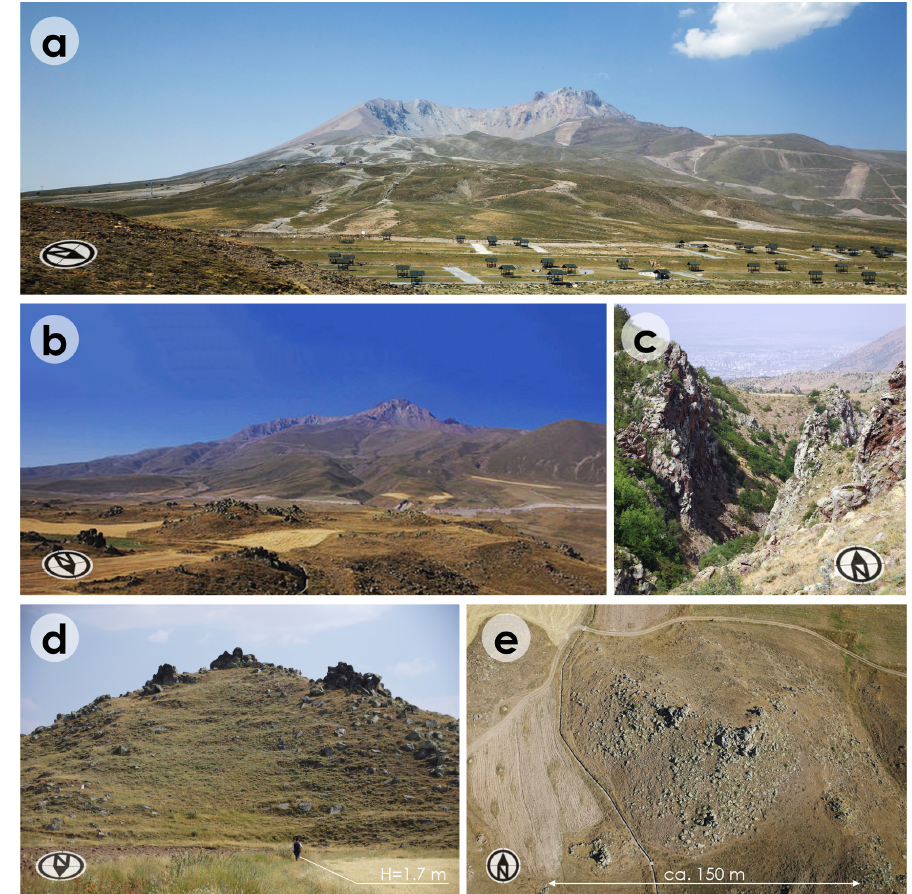
Figure 2. Pictures of the study area. Locations of these photos are shown in Fig. 1. (a) Collapse scar of Mt. Erciyes (photo taken westward). On the foreground is where the avalanche changed direction from east to north. The relative height of the edifice is 1800m ( ∼ 2100m a.s.l. on the foreground DAD surface and 3917m a.s.l. at the summit). (b) Mt. Erciyes and the 10 to 100m sized hummocks on the foreground (photo taken southward). (c) Downstream view of deeply incised gorge past the hummock-dominated area (photo taken northward). The incision depth is ∼ 40 to 60m. (d) Ground-based view of a hummock, ∼ 30m high (photo taken southward). (e) Aerial view of hummock in (d) with a diameter of ∼ 150m (photo without distortion